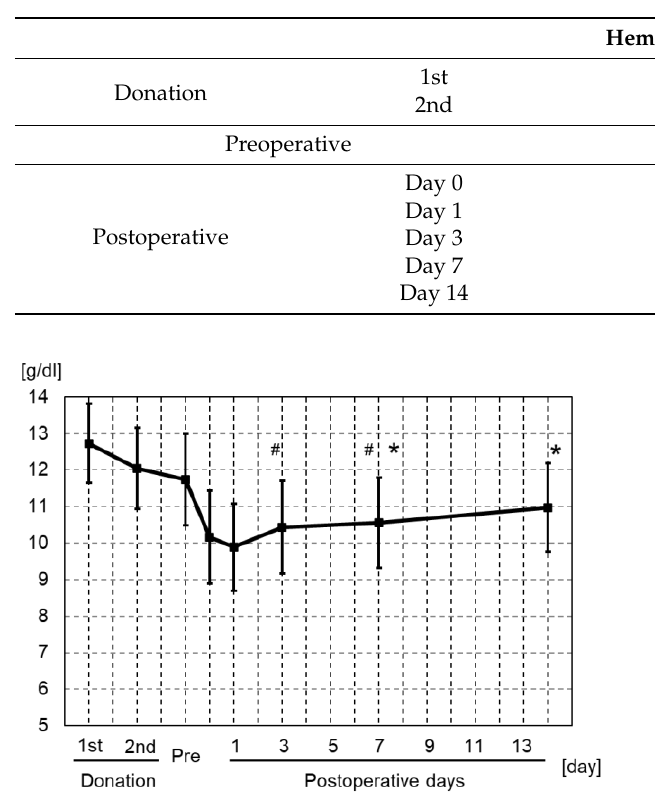
Table 2. Hemoglobin concentration during the pre- and postoperative period.